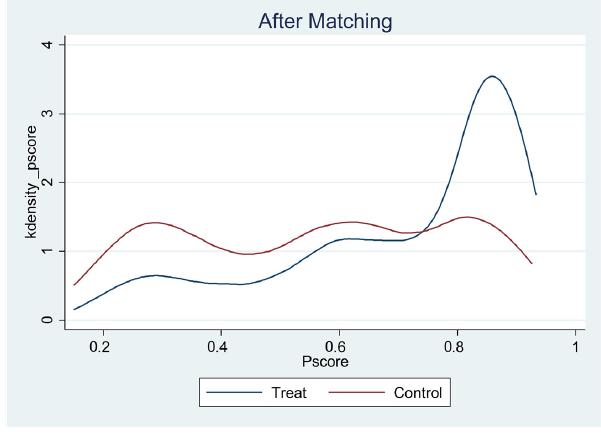
Figure 2. Distribution of propensity scores for the post-matching treatment and control groups.